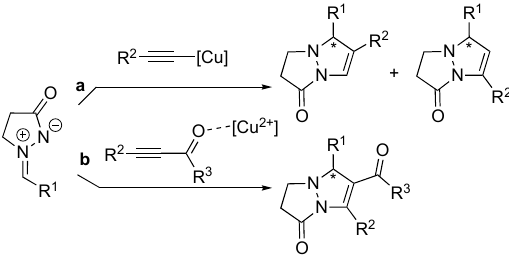
Scheme 7. Cu(I)- vs. Lewis acid-catalyzed 1,3-dipolar